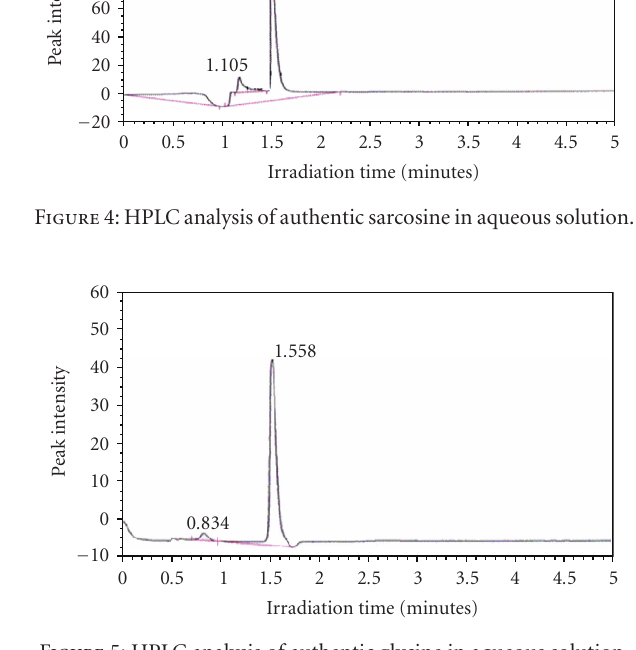
solution for 90 minutes at pH 2 led to the formation of a product which is indicated by appearance of a strong peak at R t = 1.651 minutes and a shoulder at R t =